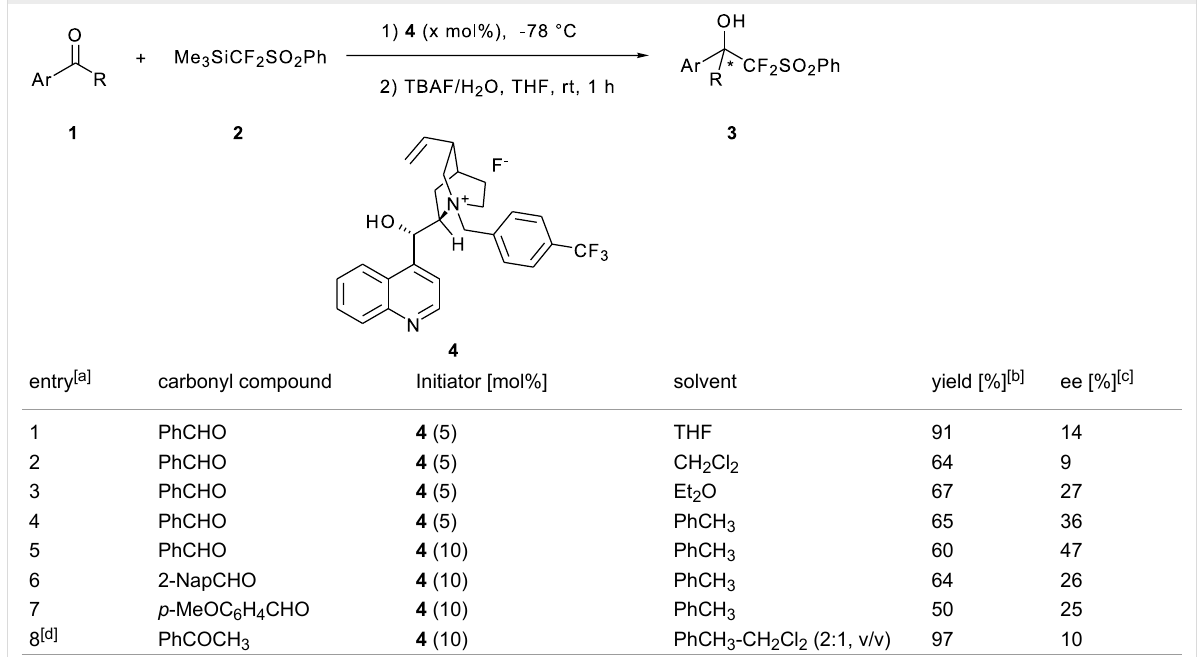
Table 1: Asymmetric nucleophilic difluoromethylation of aromatic aldehyde with PhSO 2 CF 2 SiMe 3